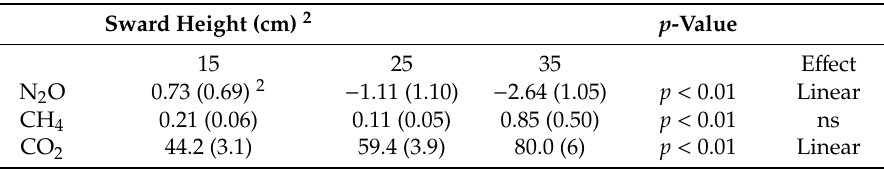
Table 7. Cumulative N 2 O (kg N 2 O-N ha − 1 ), CH 4 (kg CH 4 -C ha − 1 ), and CO 2 (Mg CO 2 ha − 1 ) emissions for Marandu grass managed at di ff erent sward heights 1 . Sward Height (cm) 2